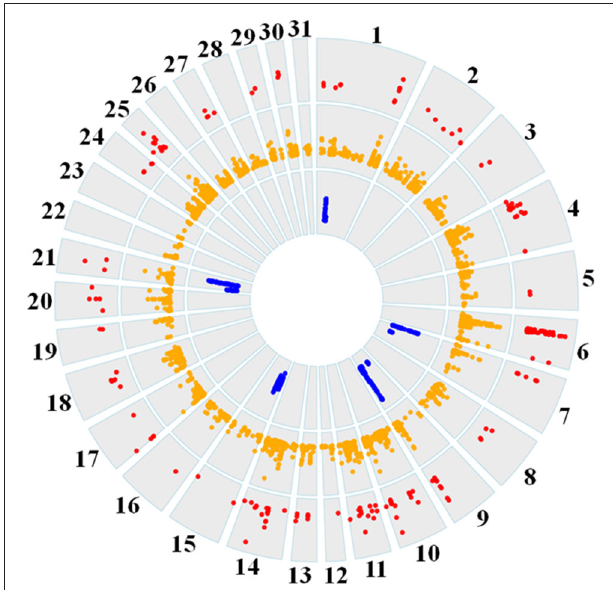
FIGURE 4 | Circos plot showing genome-wide significant d i values (red layer), hapQTL values (orange layer), and hapFLK values (blue layer) across all 31 autosomes for the reining QH subpopulation.